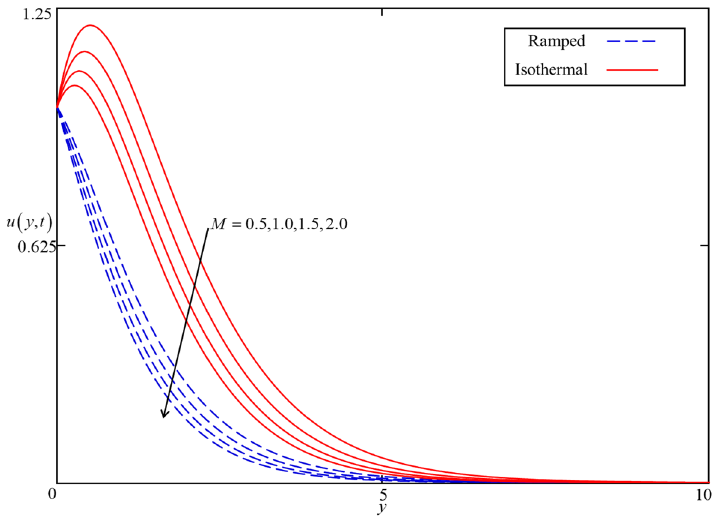
Figure 15. Consequence of M on u case of cylindrical shape nanoparticles.